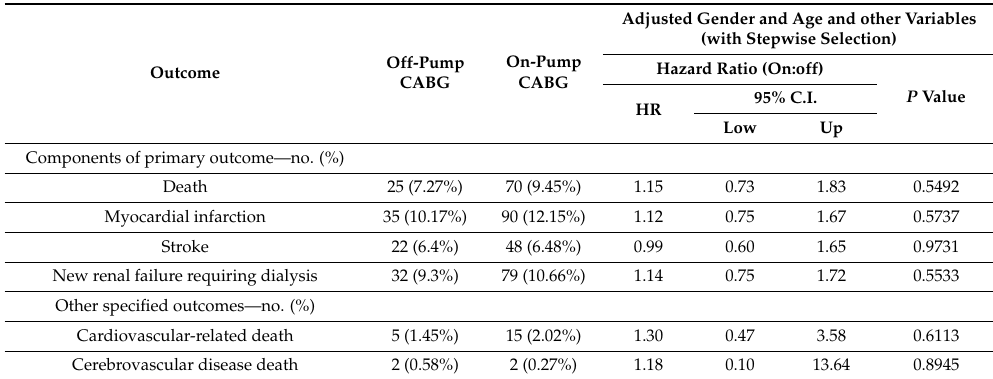
Table 5. Outcomes followed by